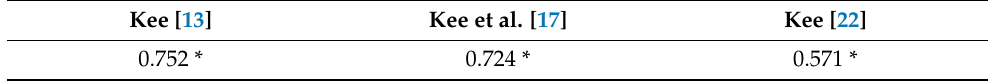
Table 4. Spearman correlation coefficients between the risk levels evaluated by the LEBA and RULA.